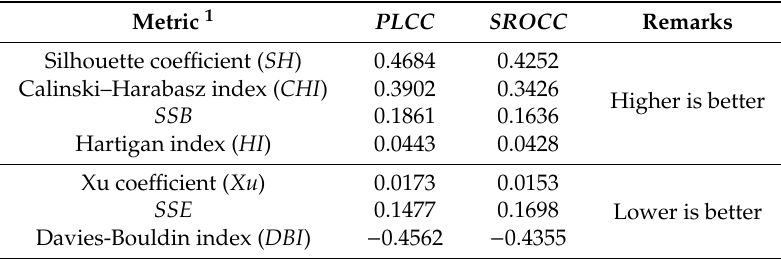
Table 7. The overall correlation between subjective MOS scores and internal validation scores.